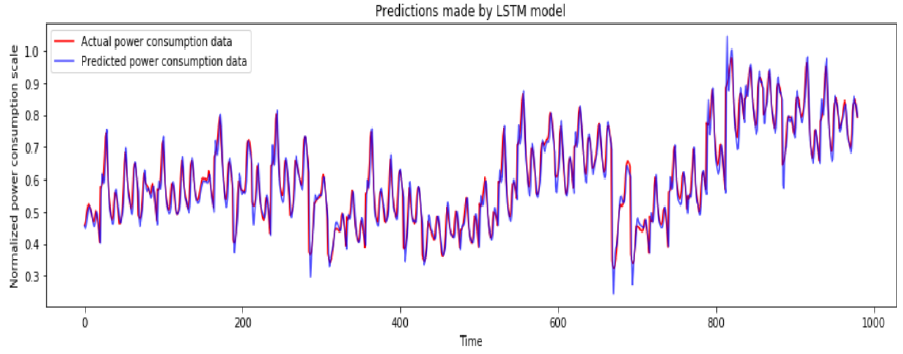
Figure 9. Forecast result of LSTM model with respect to test dataset over time (day).